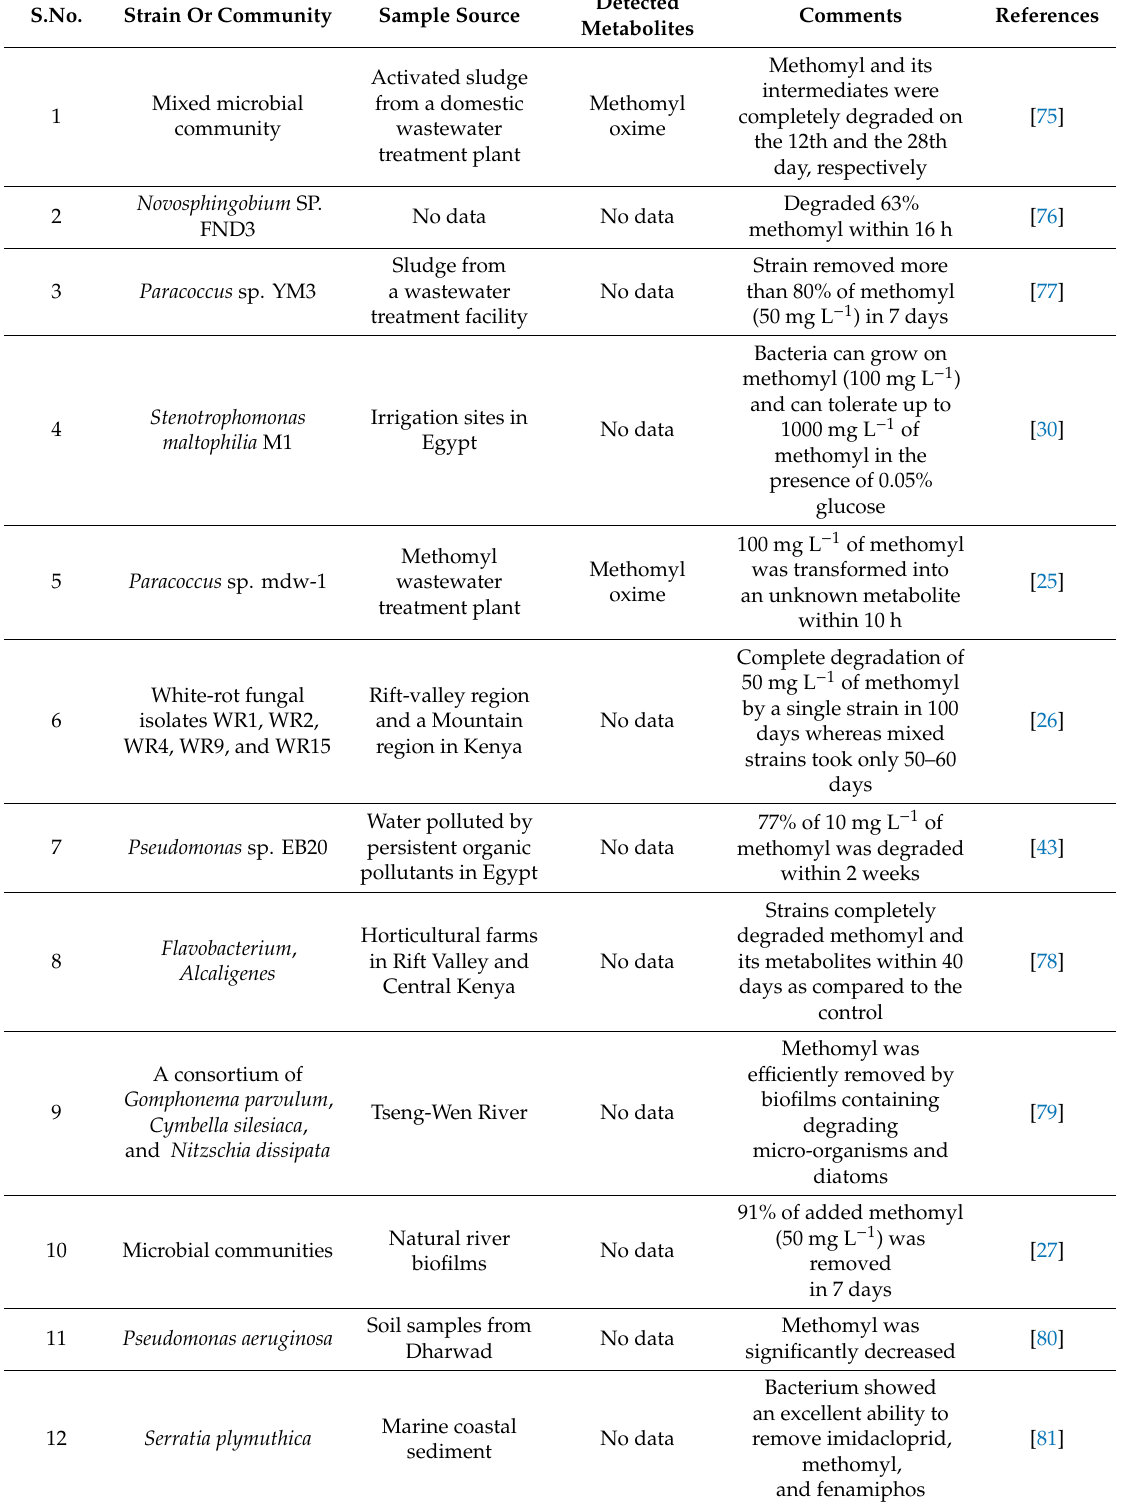
Table 3. Microbial degradation of